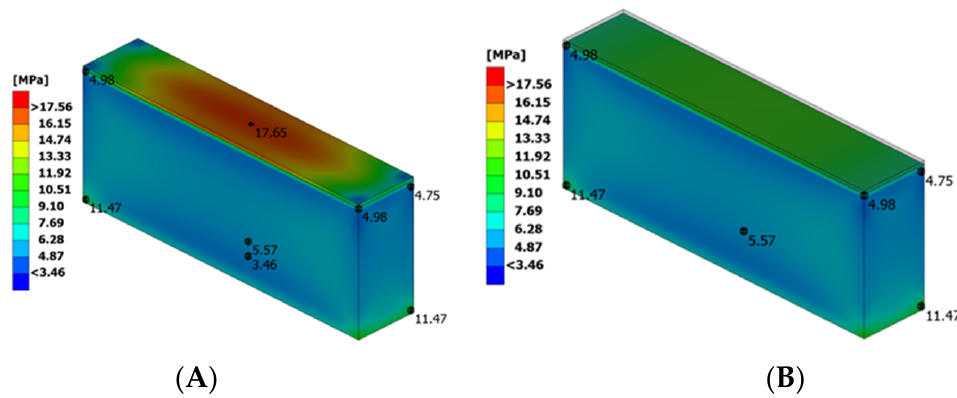
Figure 11. The results of the V02 static analysis (spraying Ni-7Cr-3Fe + 60% WC + polymer 23). ( A ) Stress concentration on the surface layer of spraying; ( B ) stress concentration on the polymer-con- crete surface under spraying (the spraying layer is hidden).